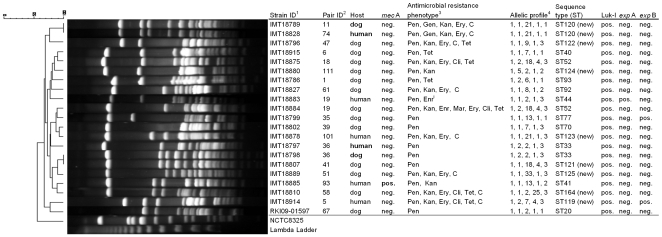
Comparative PFGE analysis and strain characteristics of S. pseudintermedius from human and canine origin.Dendrogram (percent similarity) showing DNA restriction pattern after digestion with SmaI for all 21 MSSP and MRSP isolates. PFGE analysis by use of bionumerics® (unweighted-pair group method using average linkages), dice coefficient, 1.2% tolerance and 0.5% optimization. Pair 36 comprised the isolates IMT18797 (canine) and IMT18798 (human), which show indistinguishable PFGE pattern. The canine isolate IMT18789 and IMT18828 (human) share an indistinguishable pulsotype as well, although they did not compose a dog/dog owner pair. 1Strain collection number: IMT: Institute of Microbiology and Epizootics. RKI: Robert Koch-Institute (Wernigerode branch). 2Individual number for each of the participating dog/dog owner pairs. 3Determined by use of VITEK® 2 (bioMerieux) according to the manufacturers instructions. 4Allelic profile of the genes pta, cpn60, tuf, 16S rRNA and agrD. Abbreviations: PEN, Penicillin G; GEN, Gentamicin; KAN, Kanamycin; ENR, Enrofloxacin; MAR, Marbofloxacin; ERY, Erythromycin; CLI, Clindamycin; TET, Tetracycline; CHL, Chloramphenicol; i: susceptibility testing result: intermediate. Luk-I: Leukotoxin I (lukS and lukF), expA: Exfoliative toxin A (primer: this study), expB: Exfoliative toxin B.